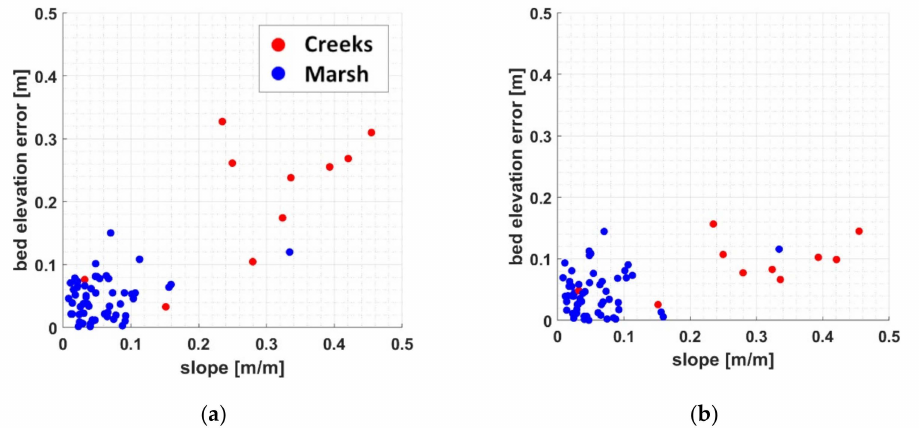
Figure 4. Comparison between the bed elevation errors and the ground slope calculated at surveyed locations close to the creeks (red dots) and at the marsh platform (blue dots) by using ( a ) the non- transformed LiDAR-UAV point cloud and ( b ) the LiDAR-UAV point cloud we transformed by using the transformation method of Pinton et al.